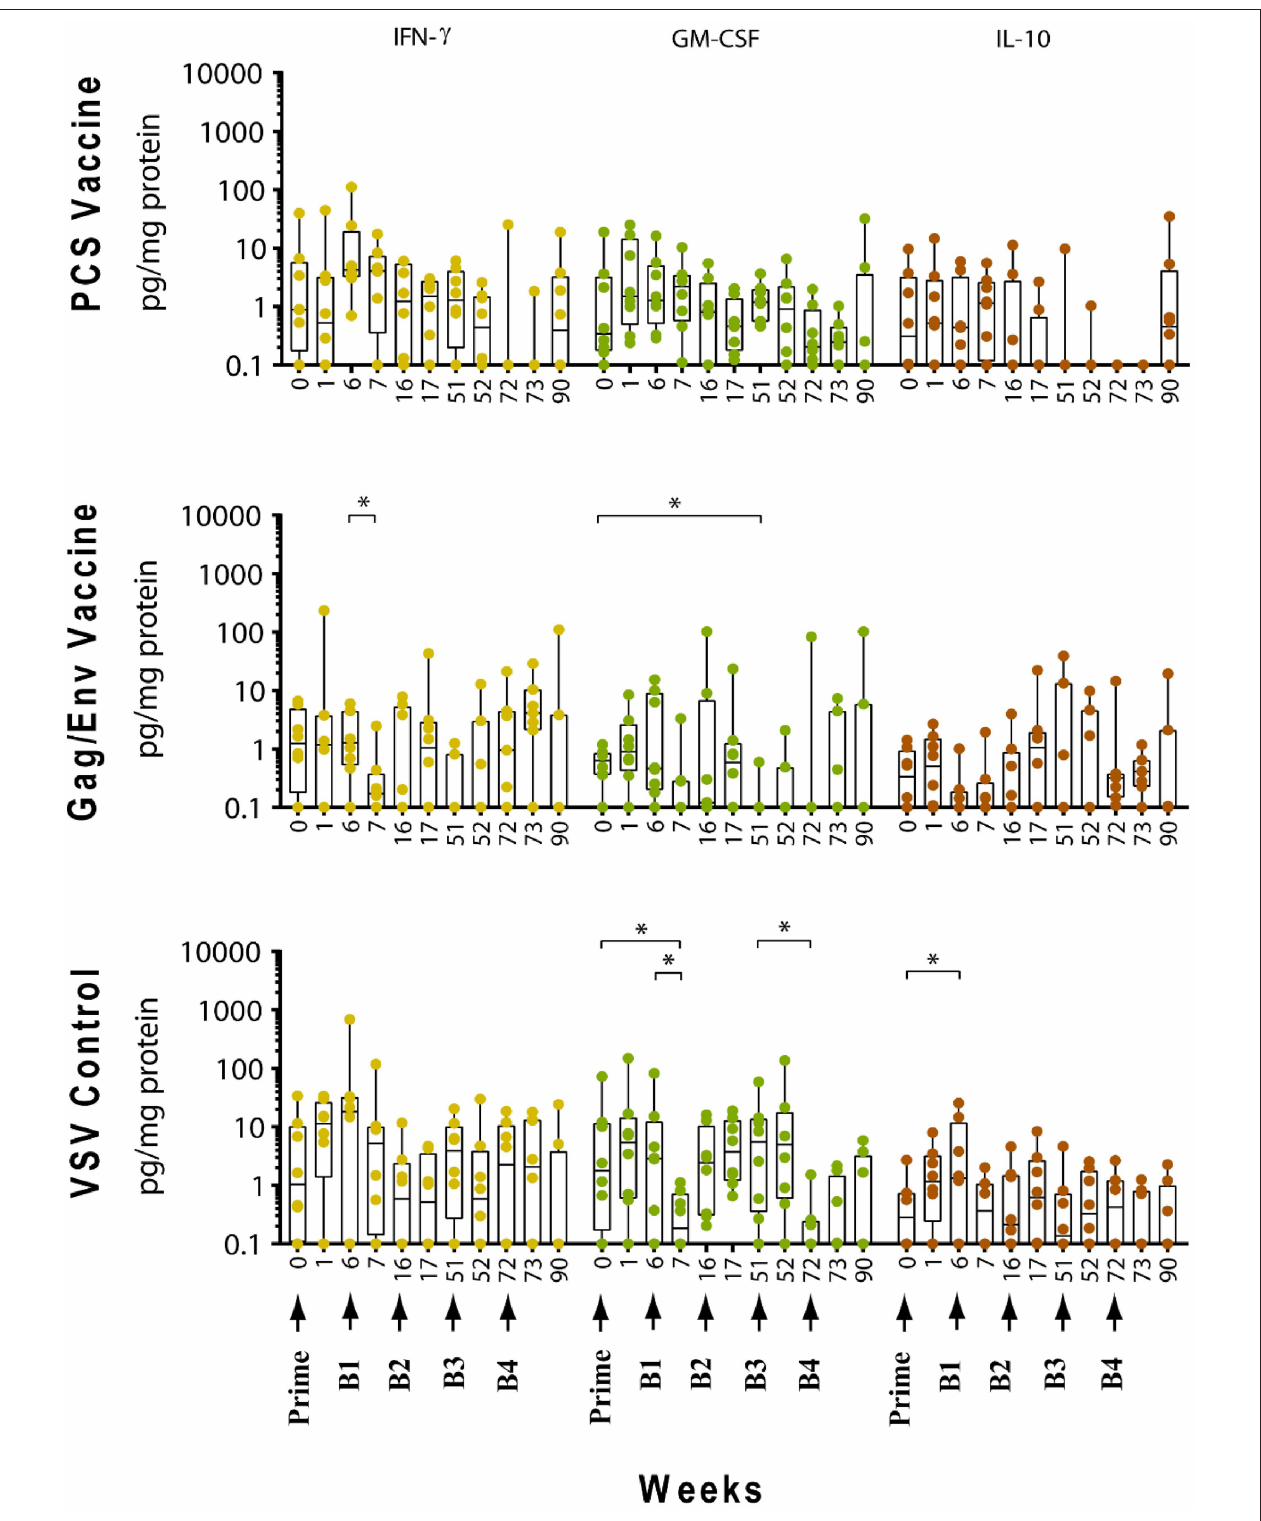
FIGURE 5 | Significant changes in the CVL levels of IFN- γ , GM-CSF, and IL-10 after immunization and multiple boosts analyzed using Wilcoxon matched- pairs signed-rank paired t -test. Data presented as values from individual monkeys with median and range. Arrows indicate immunization. n = 8 monkeys/group ( n = 7 for Gag/Env). Experiments were run in duplicates. * P <